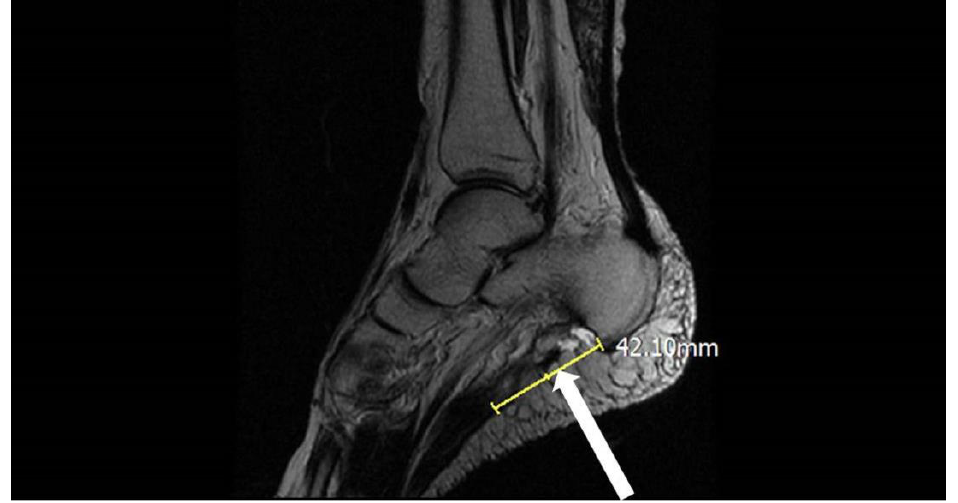
Figure 1. The white arrow indicates the complete rupture of the planta fascia with a 4.2-cm gap between the distal fascia stump and the calcaneal tuberosity on an MRI sagittal view.